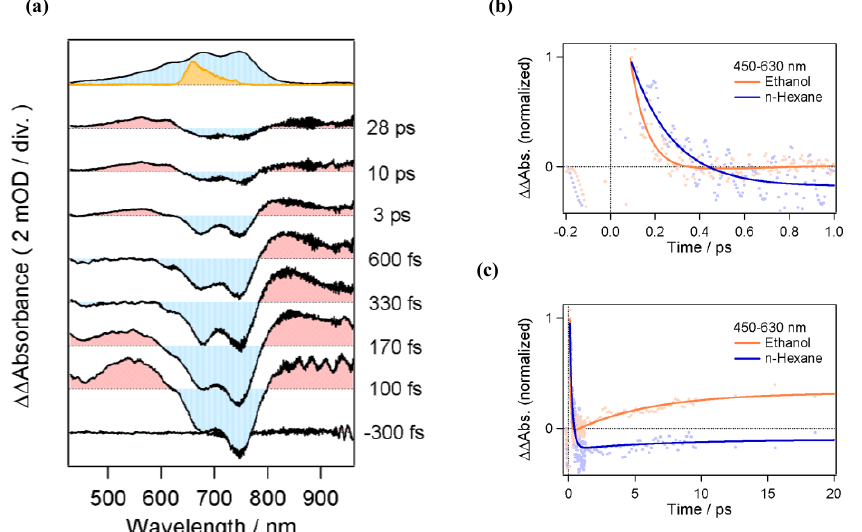
Fig. 2. (a) ΔΔAbsorption spectra of TMPD in ethanol solution excited with pump1 (340 nm, 320 nJ) and pump2 (680 nm, 740 nJ). The delay time was a time interval between pump2 and probe pulses. The delay of pump 1 was fixed to be -10 ps. The spectrum of pump 2 (orange) and transient absorption spectrum observed at 10 ps after pump 1 irradiation (blue) are shown at the top of the figure. (b,c) Time profiles of transient absorbance of TMPD in ethanol (orange lines) and n -hexane (blue lines) averaged over 450-630